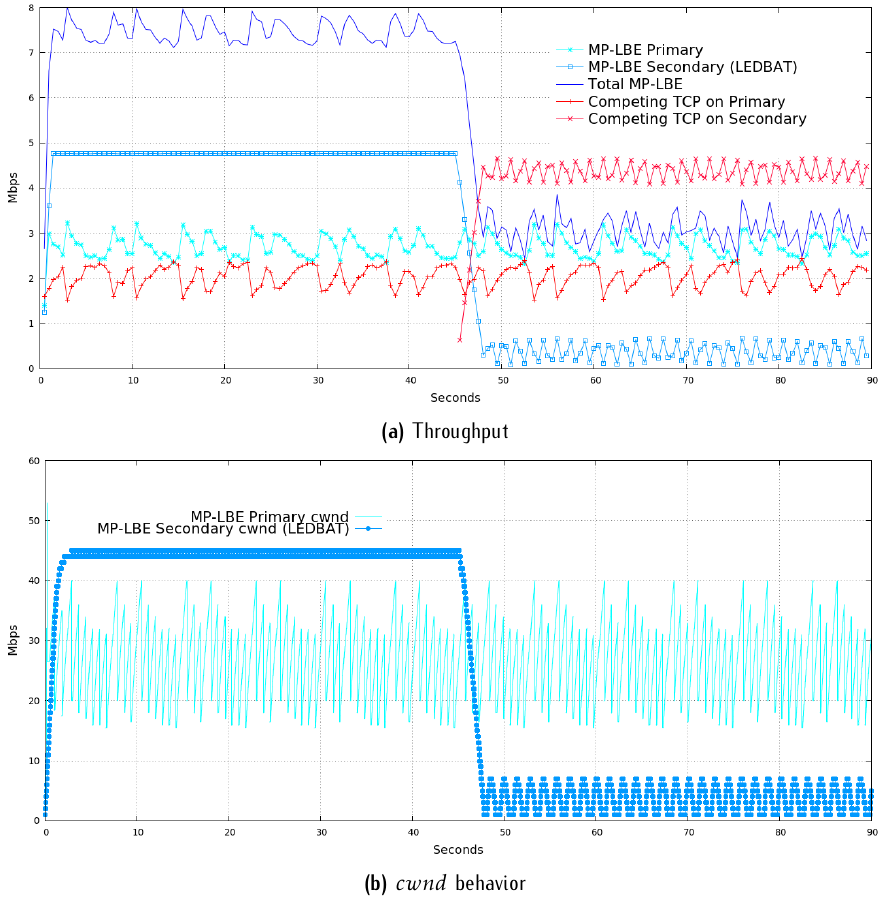
Figure 5. LBE Behavior of MP-LBE using